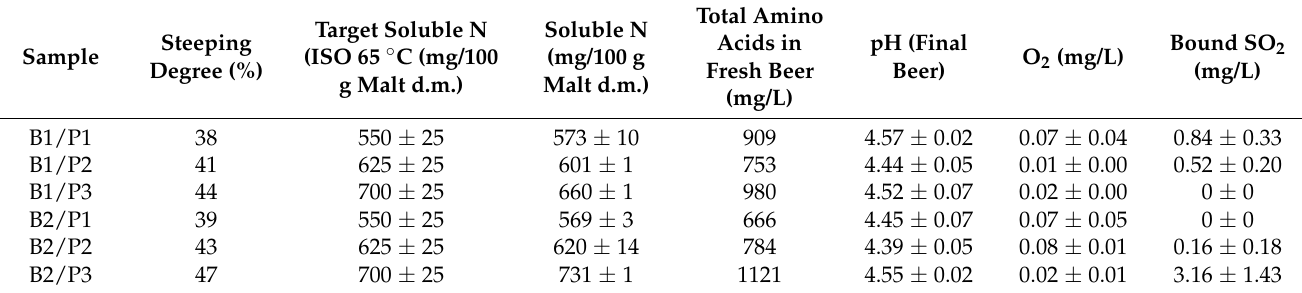
Table 1. Malt and brewing specifications: steeping degree, soluble N (target and real), total amino acids, pH, O 2 , and bound SO 2 .